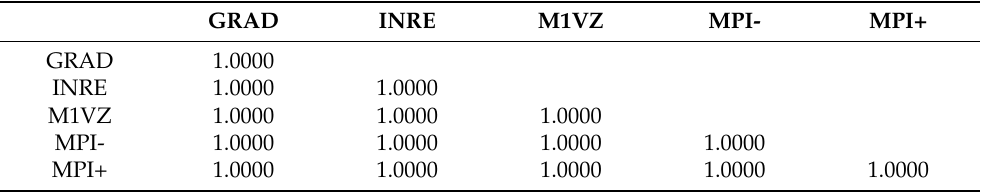
Table 5. SP-score. Cograduation matrix of five aggregation